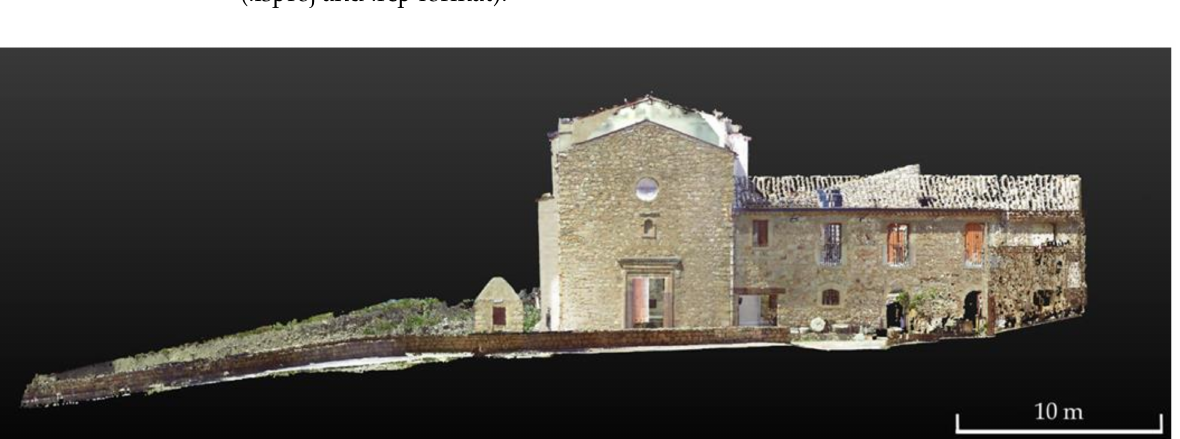
Figure 8. Frontal view of the 3D dense cloud, after the alignment and cleaning processes.